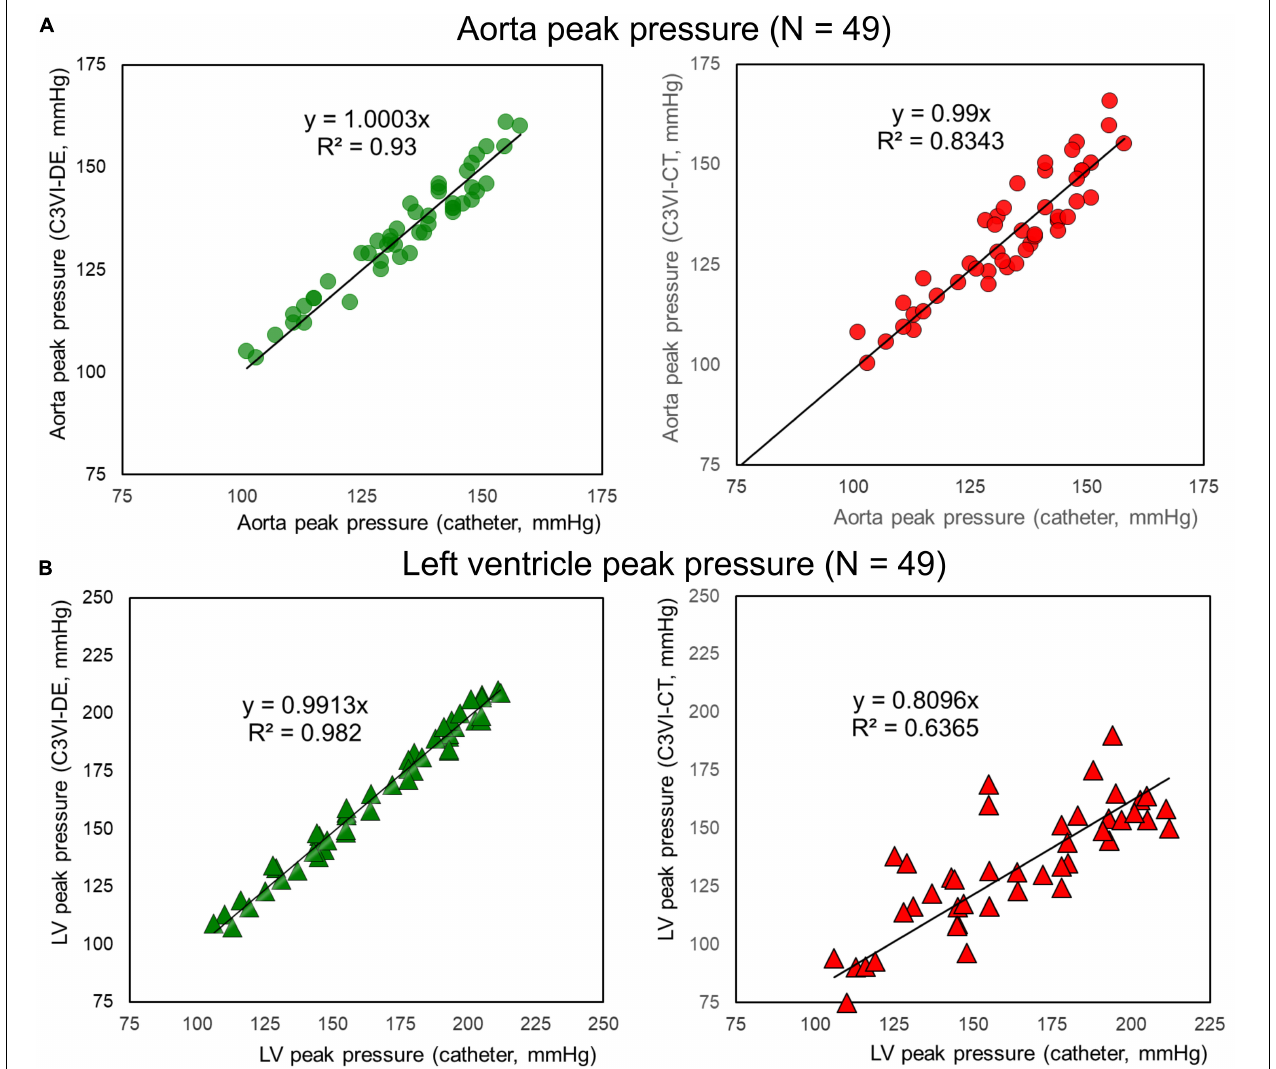
FIGURE 4 | Peak pressure correlation (C3VI-CT & C3VI-DE vs. cardiac catheter). Peak pressures calculated by C3VI-DE correlated well with catheter measurements in all forty-nine C3VI patients, described by high coefficients of determination. In contrast with C3VI-DE, peak pressures obtained from C3VI-CT are incompatible with the catheter measurements, described by low coefficients of determination. (A) Aorta. (B) Left